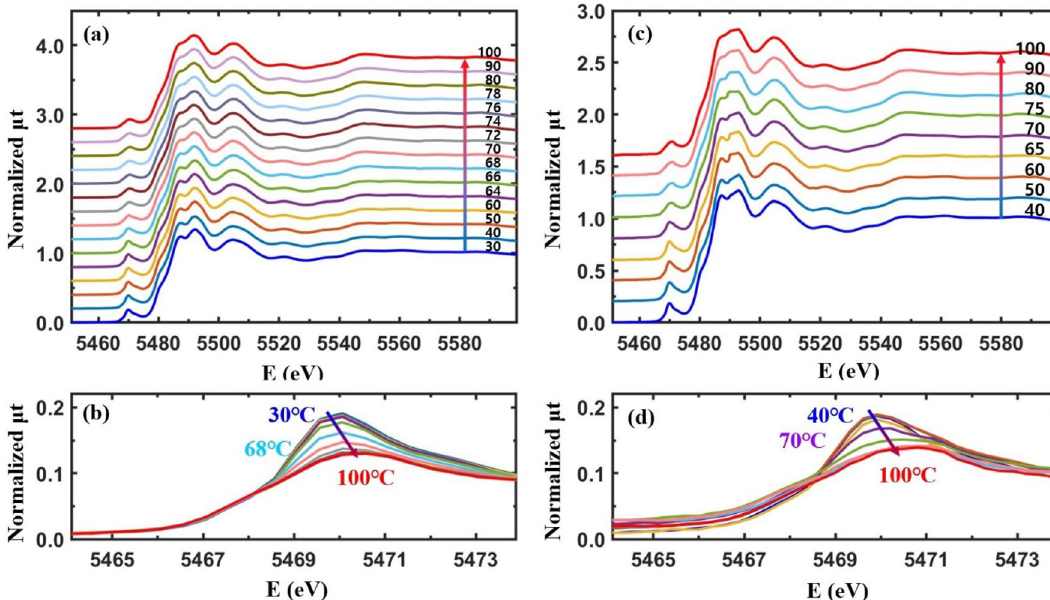
Figure 4. ( a , c ) Normalized temperature-dependent XANES (μt) from a pristine VO 2 film and the Cr-VO 2 film with a Cr ion energy of 30 keV and a flux of 10 12 ions/cm 2 during heating. ( b , d ) are the magnified images of the pre-edge peaks in ( a , c ), respectively. Data in ( a , c ) are vertically shifted for